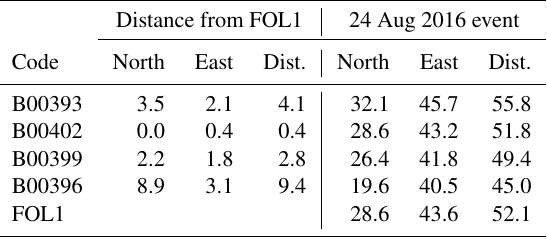
Table 2. Distances in km between the MEMS accelerometers and the Foligno CGPS site (FOL1, Fig. 5), and the earthquake epicen- tre of 24 August 2016 event. The North and East columns contain the distance along these horizontal components, while in the Dist. columns we report the modulus of the horizontal